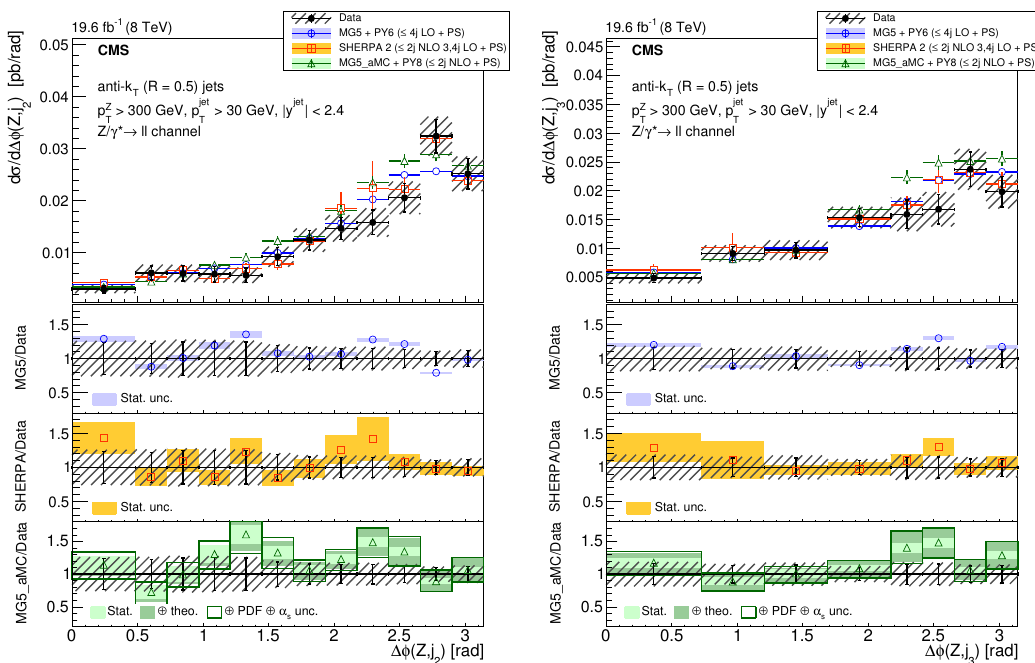
Figure 23 . The di(cid:11)erential cross section for Z ( ! ‘‘ ) + jets production for N jets (cid:21) 3 and p T (Z) > 300 GeV as a function of the azimuthal angle (left) between the Z boson and the second- leading jet and (right) between the Z boson and the third-leading jet. The lower panels show the ratios of the theoretical predictions to the measurements. Error bars around the experimen- tal points show the statistical uncertainty, while the cross-hatched bands indicate the statistical and systematic uncertainties added in quadrature. The boxes around the mg5 a mc + pythia 8 to measurement ratio represent the uncertainty on the prediction, including statistical, theoretical (from scale variations), and PDF uncertainties. The dark green area represents the statistical and theoretical uncertainties only, while the light green area represents the statistical uncertainty